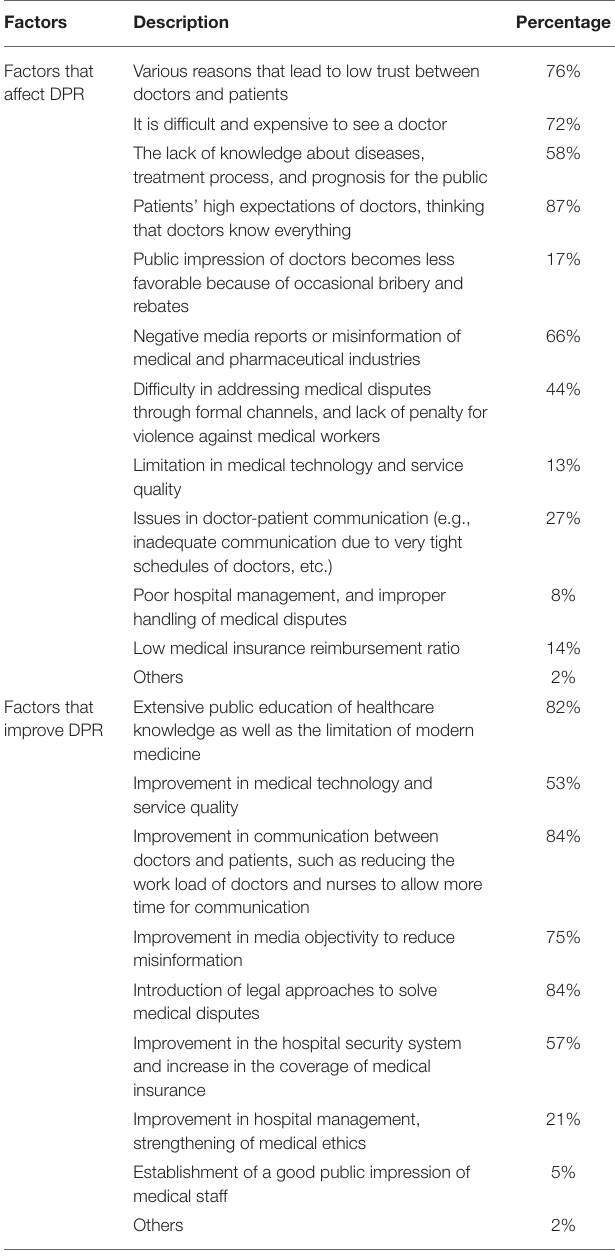
TABLE 2 | Factors that affect and improve doctor-patient